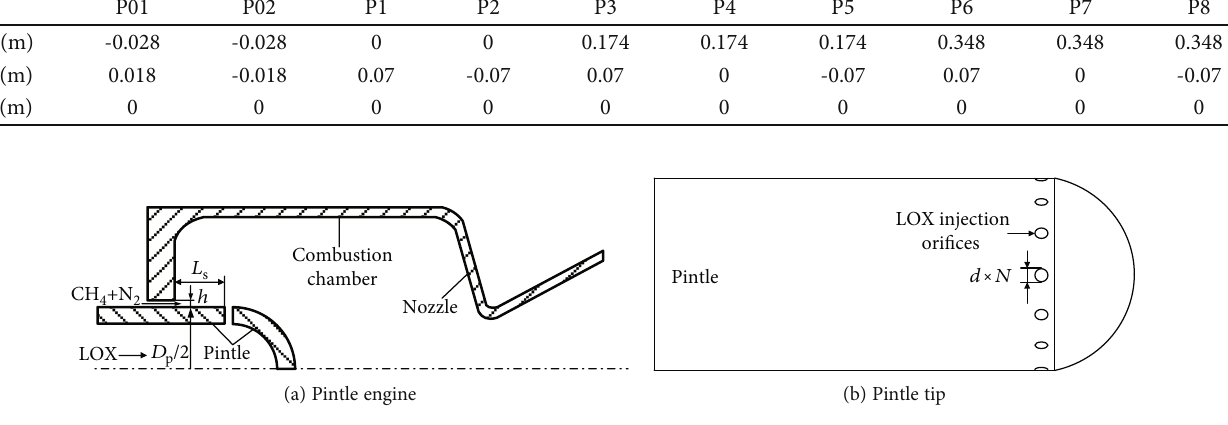
Figure 2: Schematic of LOX/GCH Table 2: Main structural parameters of the pintle injector.